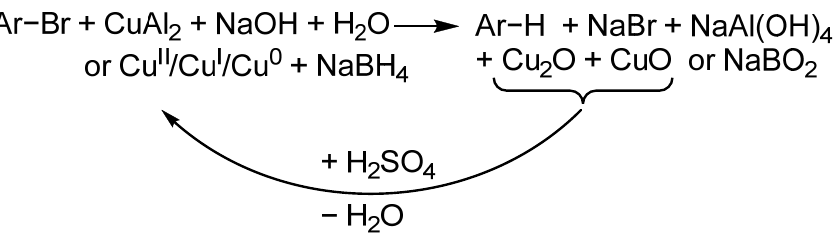
NaOH; Table S8: HDB of TBBPA after overnight reaction using different HDB agents. Figure S1: Powder X-ray diffractograms of undissolved residues of reused Dev. alloys; Figure S2: Effect of repeated application of Dev. alloy in the coaction of NaBH 4 ; Figure S3:HDB rate of 5 mM aq. BRX dissolved in 20 mM NaOH mediated by the Dev. alloy (7.1 g/L) under the coaction of NaBH 4 (8